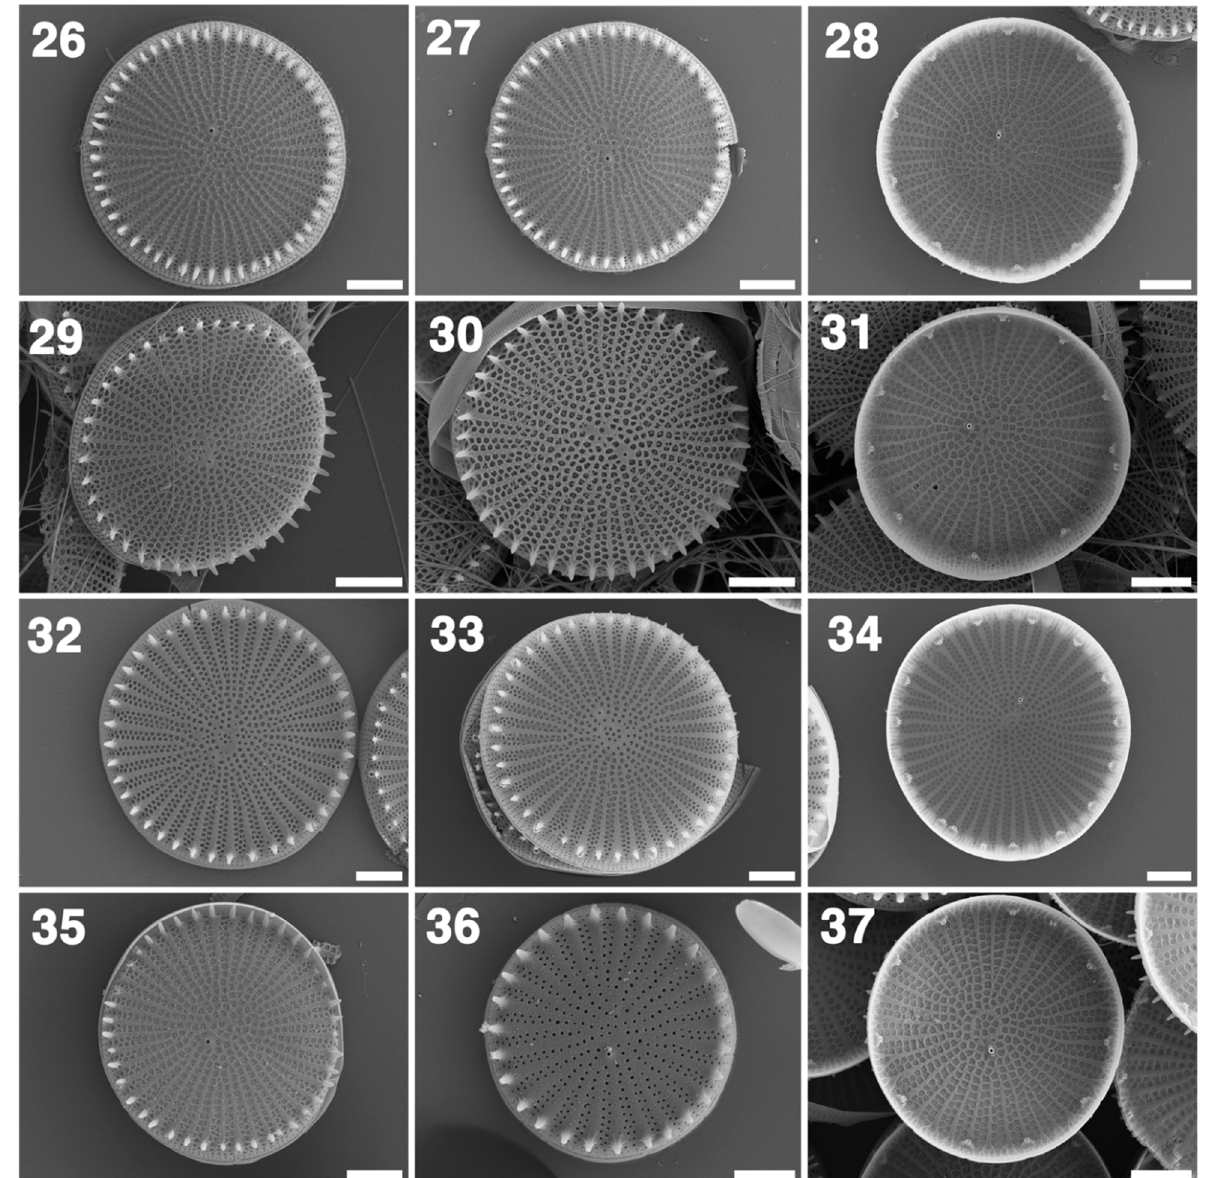
Figure 4. ( 26 – 37 ) SEM photographs of the internal and external ultrastructure of Cyclostephanos invisitatus . ( 26 – 28 ) strain W13; ( 29 – 31 ) strain M10; ( 32 – 34 ) strain GC4; ( 35 – 37 ) strain SN34. Scale bars = 2 µm.